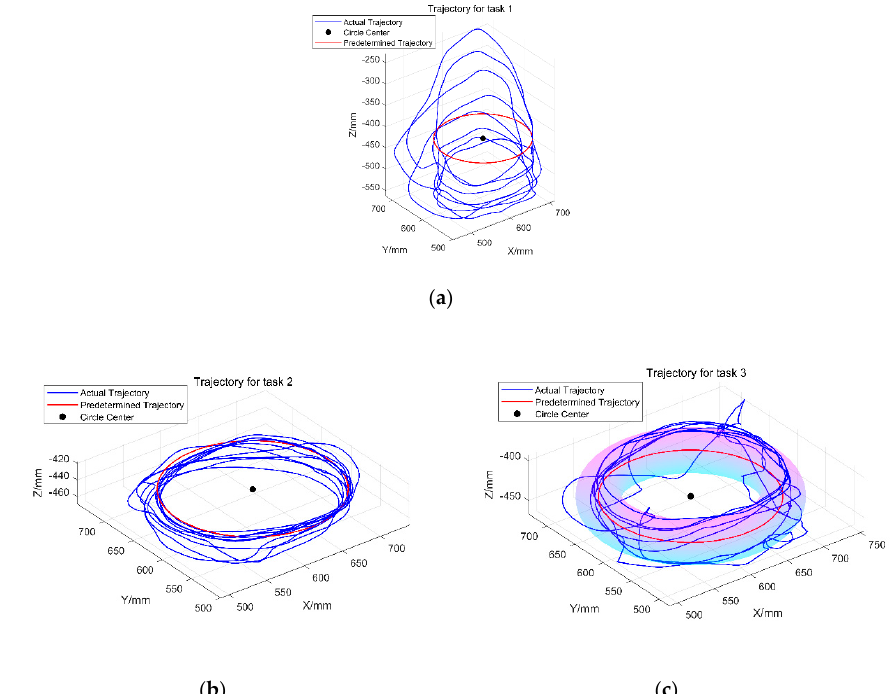
Figure 10. The trajectory of the subject’s hand during the three testing tasks. ( a ) the trajectory of subject’s hand for the task1; ( b ) the trajectory of subject’s hand for the task2; ( c ) the trajectory of subject’s hand for the task3.